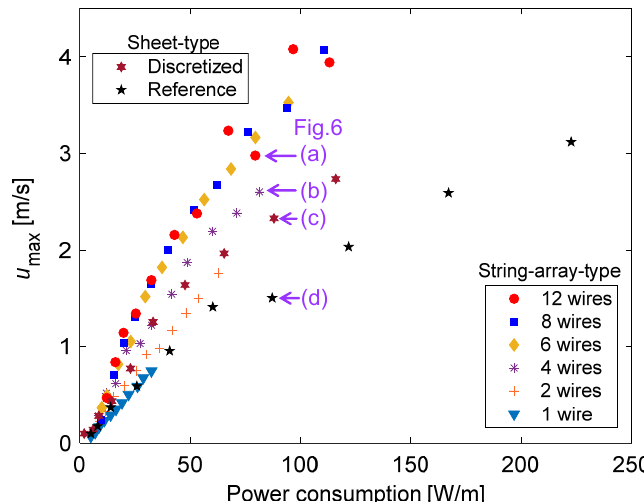
Figure 7. u max as a function of power consumption at x = 15 mm downstream of the exposed electrode edge. The four conditions indicated by the arrows are shown in Figure 6 for comparisons of the velocity distributions of the induced flow.